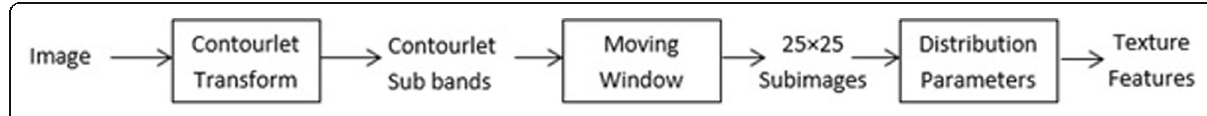
Fig. 13 Feature extraction process in contourlet domain